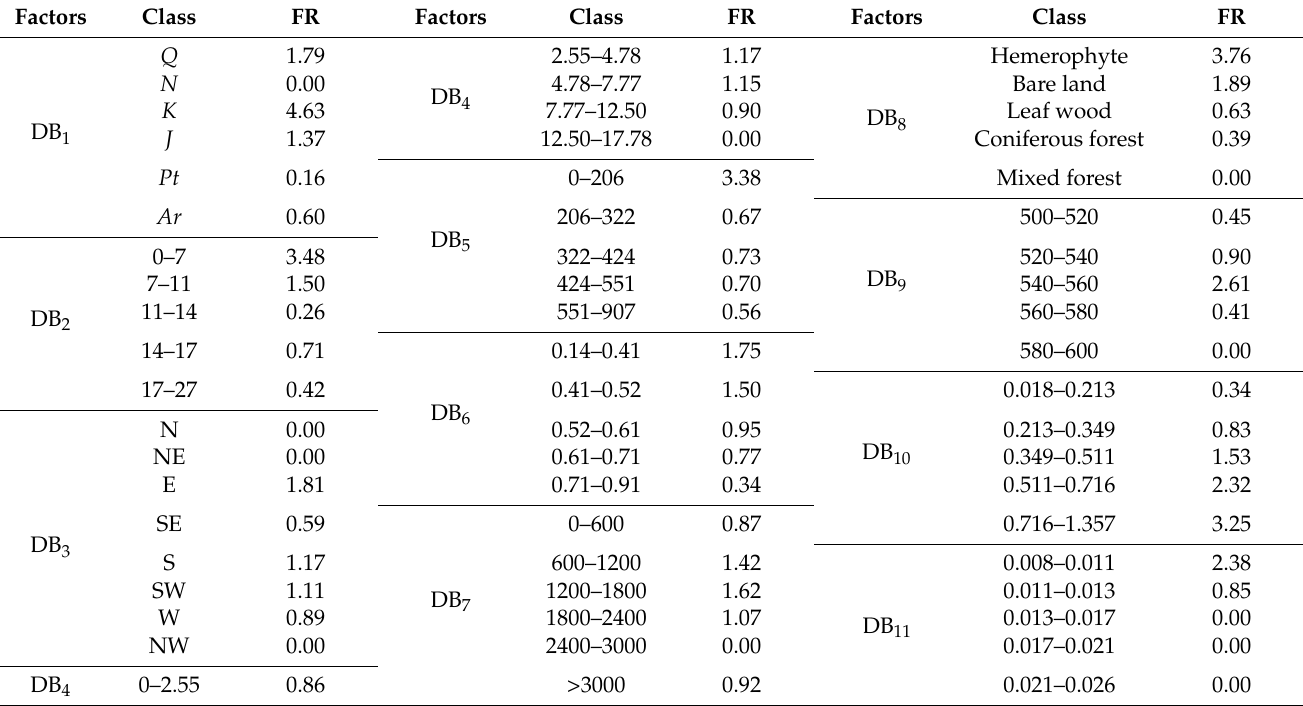
Figure 7. Importance of debris flow conditioning factors for the SVM and ANN models. Table 7. Statistics of FR values of each subclass of the debris flow conditioning factors.